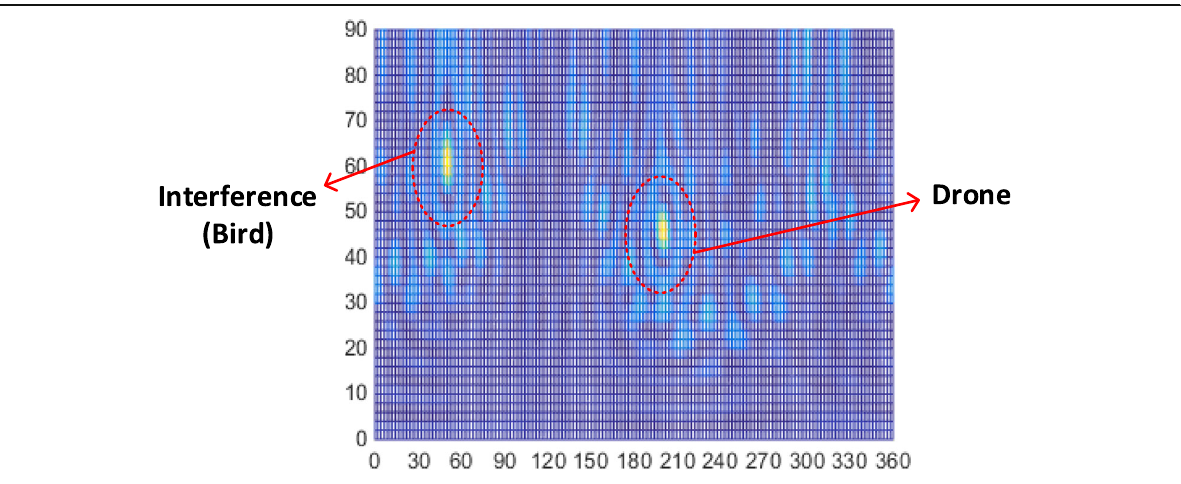
Fig. 9 Color map of output power [direction of drone (45°, 200°); direction of bird (60°, 50°)]